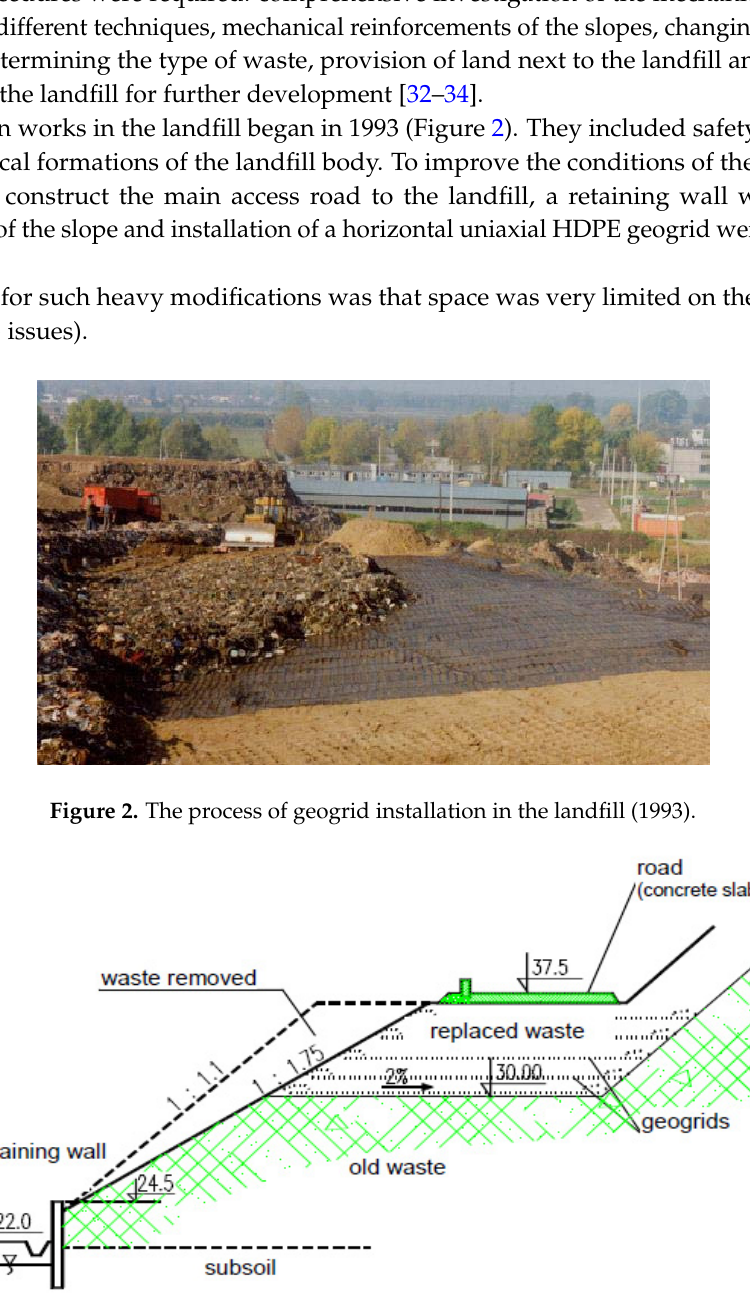
Figure 3. Cross ‐ section and reinforcements in the northern slope of the landfill [31].